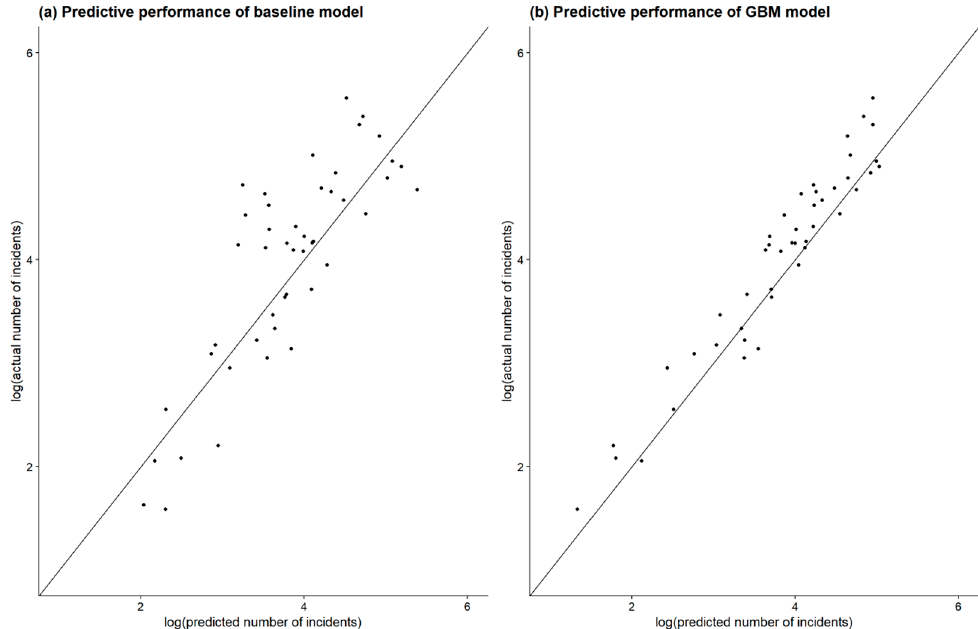
Figure 4. Comparison of the geographically aggregated predictive performance of the baseline vegetation model ( a ) with the implemented GBM vegetation model ( b ) for the test set (4 April 2020 to 4 April 2021). The correlation of predictions against observed incident counts is considerably better for the gbm model (0.97) compared with the baseline model (0.82). The solid line represents the line y = x, which corresponds to the case of perfect correlation between prediction and result.